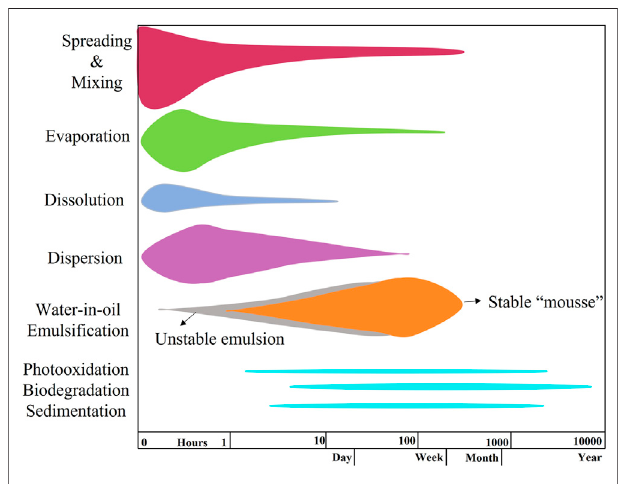
FIGURE 3 | The weathering process overtime after the oil is released to the surface of the water (Lee et al., 2015).